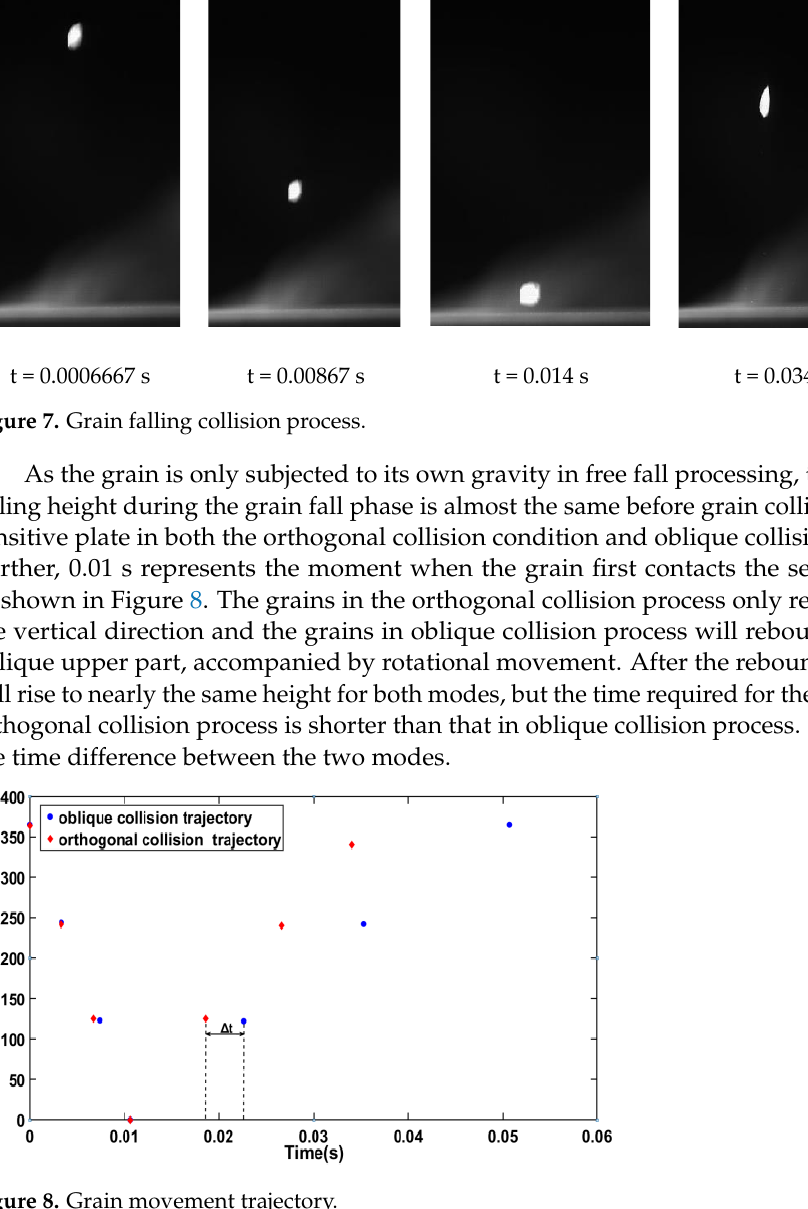
Figure 6. Installation of the grain loss sensor in combine harvesters and field experiment. ( a ) Instal- lation of the grain loss sensor, ( b ) perforated bags ( c ) field experiment. 1 — grain loss sensor, 2 — perforated bags .